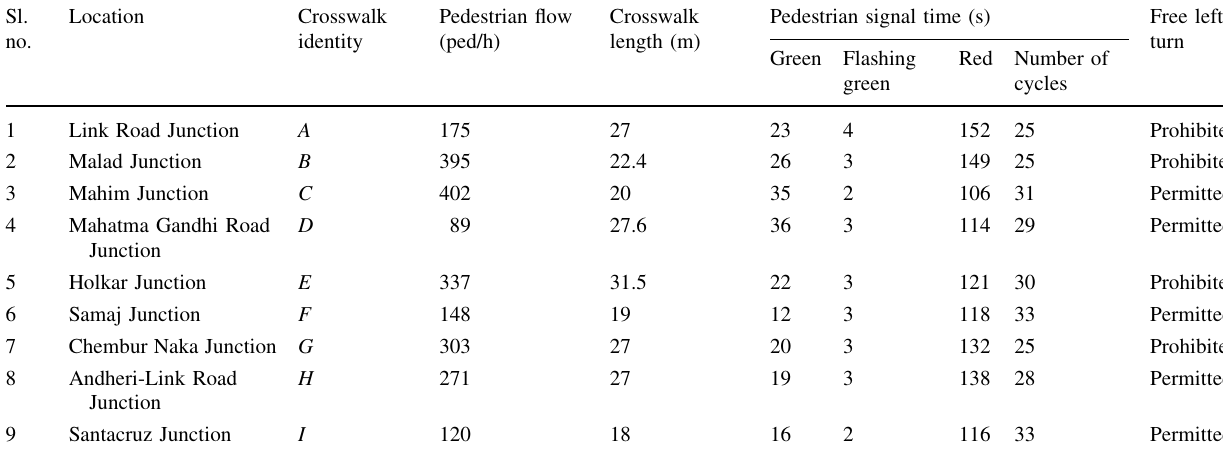
Table 2 Selected study locations and basic information Sl.